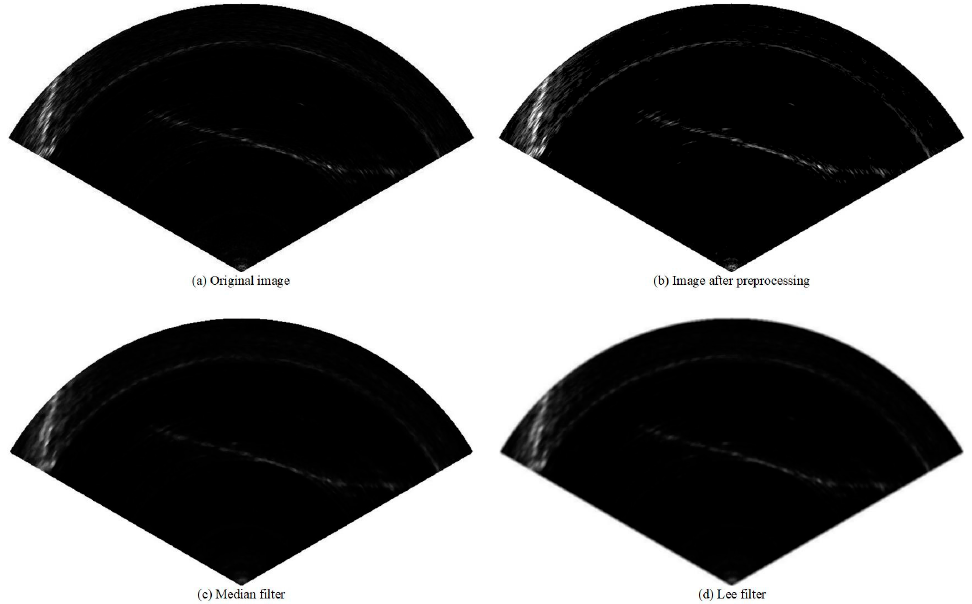
Figure 2. An example of various preprocessing methods: ( a ) the original image; ( b ) the preprocessed image with our method; ( c ) the preprocessed image with median filter; ( d ) the preprocessed image with Lee filter.